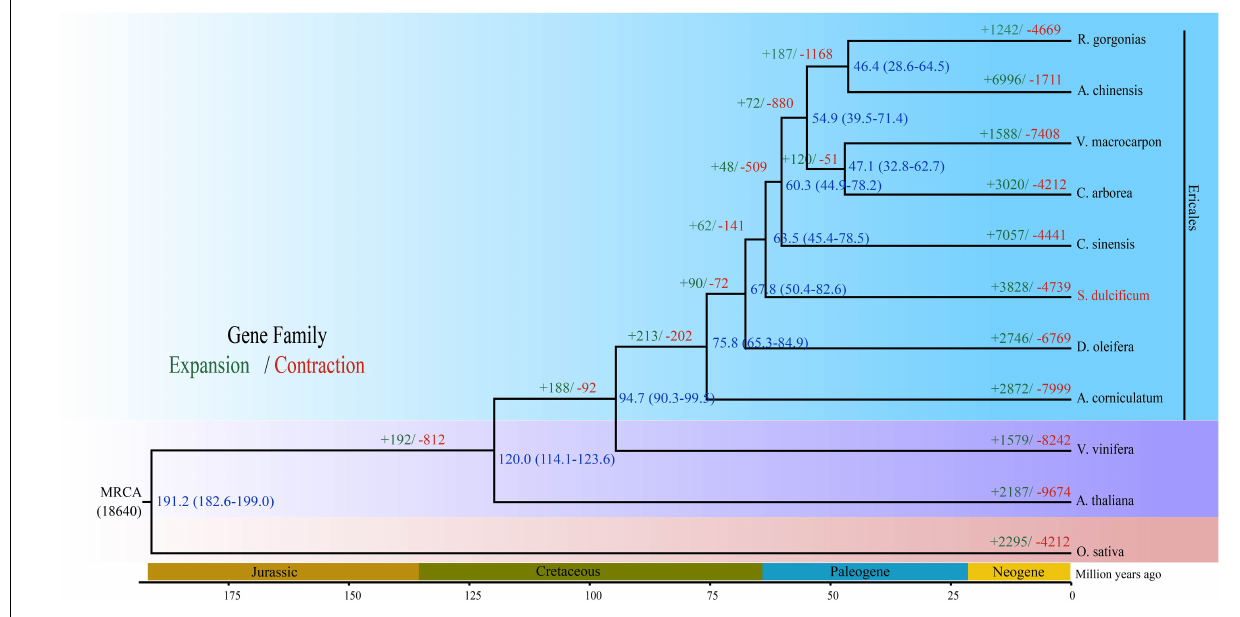
FIGURE 4 | Phylogenetic tree of S. dulcificum and 10 other species. The time of species differentiation and the expansion and contraction of gene families are denoted at each node. Green and red font numbers represent expansion and contraction of gene families, blue font words are species differentiation